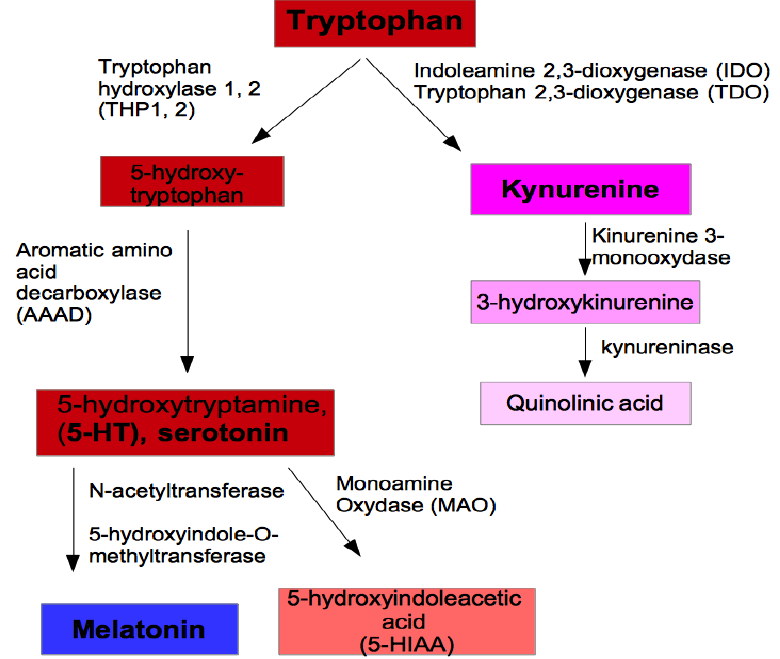
Figure 1. Metabolic pathways of tryptophan.